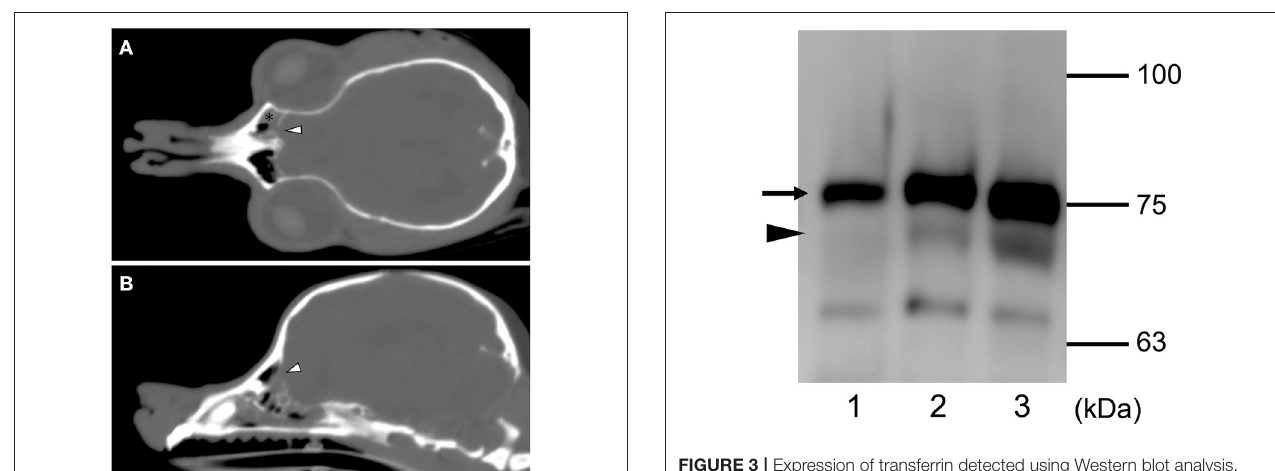
FIGURE 3 | Expression of transferrin detected using Western blot analysis. Distinct protein patterns are seen with serum ( lane 1 ) and CSF ( lane 2 ) of a control dog, and nasal leaked fluid from the present patient ( lane 3 ). The black arrow indicates the approximate position of serum transferrin, and black arrowhead indicates the approximate position of brain-type transferrin. The molecular masses of the size markers are shown on the